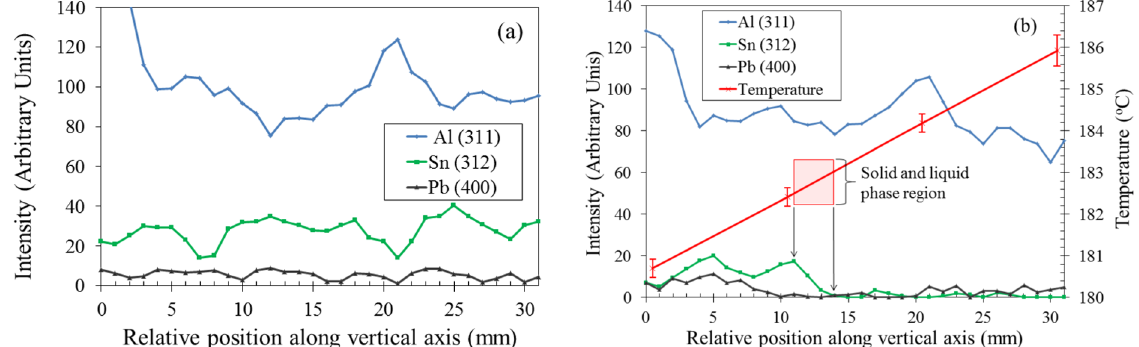
Fig. 4. (a) Intensity distribution of Al, Sn and Pb at room temperature and (b) intensity plot under static temperature